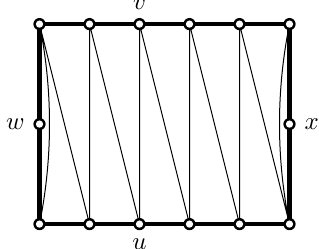
Figure 1: The cycle C with